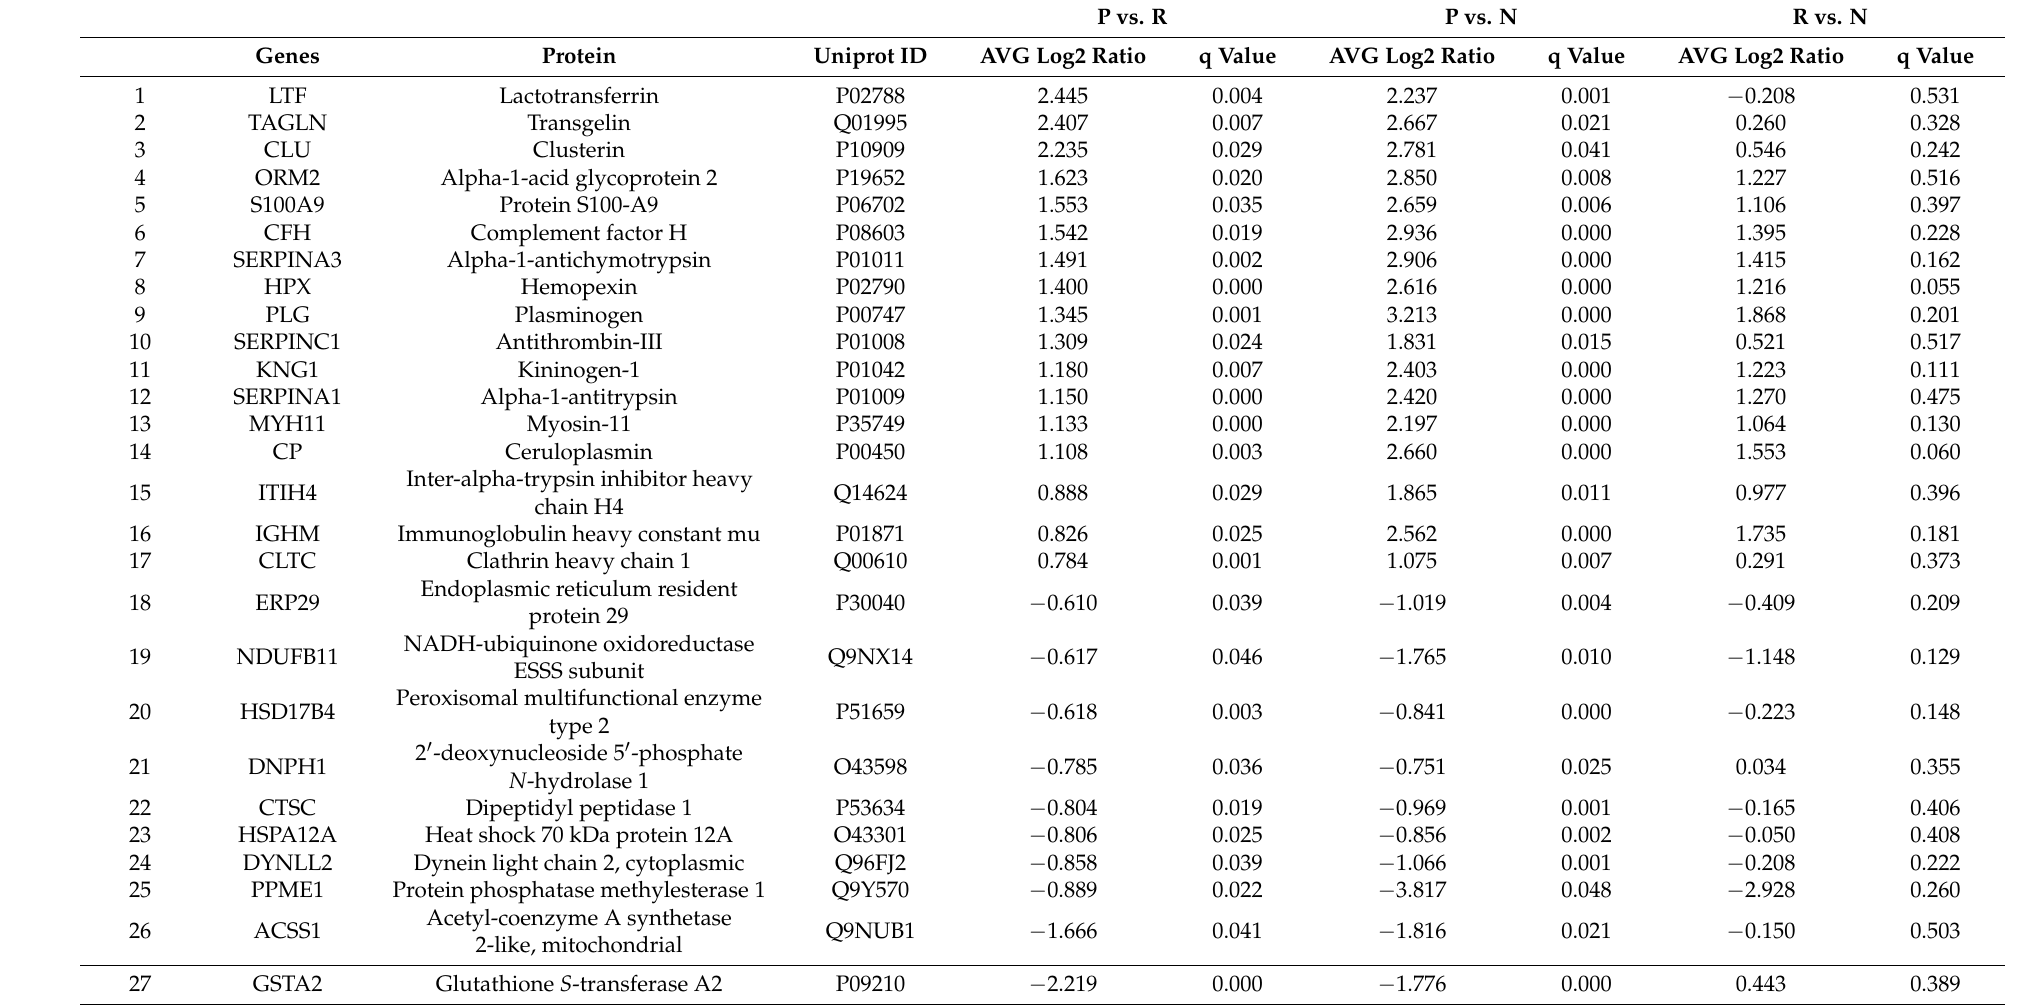
Table 2. Proteins specifically deregulated in sunitinib non-responsive vs. responsive mccRCC tumors. P vs. R P vs. N R vs.